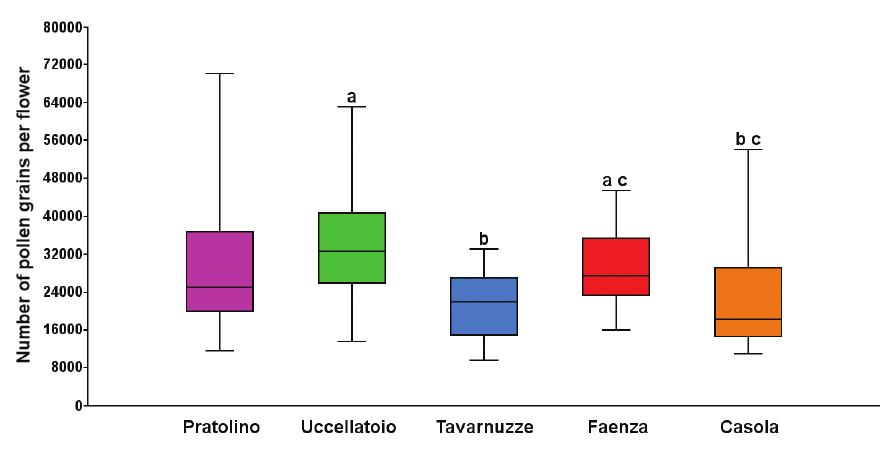
Figure 3. Boxplot of the estimated pollen grain number per flower in the studied Bellevalia webbiana populations. Different letters indicate statistically significant differences at 0.01